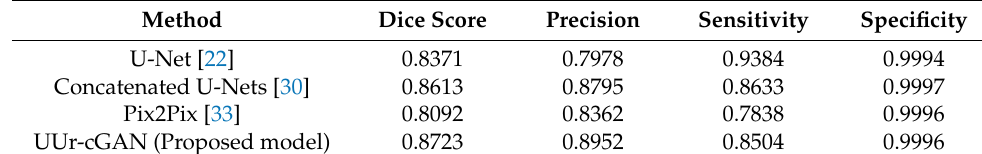
Table 2. Average k-Fold metrics for different methods and proposed model.